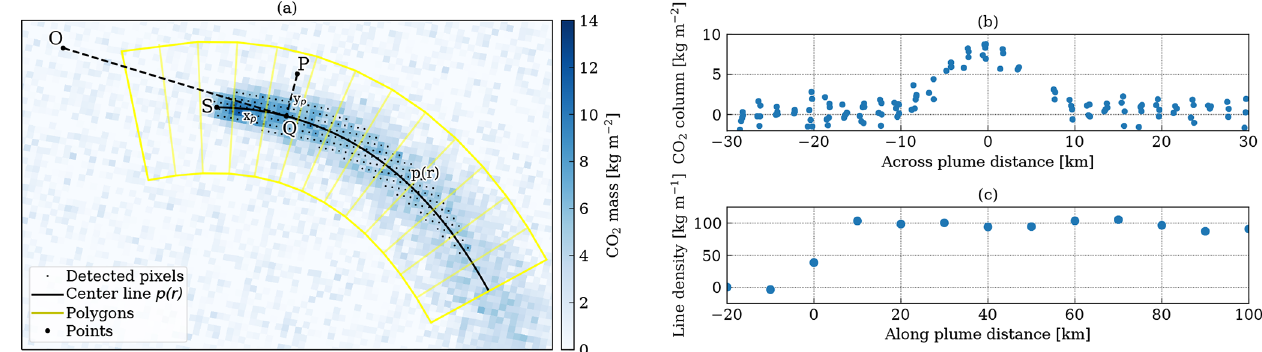
Figure 1. (a) Sketch of a CO 2 city plume with detected pixels and fitted centerline. Random noise has been added to the CO 2 observations. The center of the city source is denoted by S . The origin of the center curve is O = (x o ,y o ) . For a satellite pixel P , the across-plume coordinate y p is the distance between P and Q , and the along-plume coordinate x p is the arc length from S to Q . The yellow rectangles are the polygons used for computing the line densities. (b) Example of CO 2 mass columns in across-plume distance for the polygon containing the pixel P . (c) Line densities computed for each polygon in the sketch. The line densities are zero upstream of the source, build up over the city and remain constant downstream of the